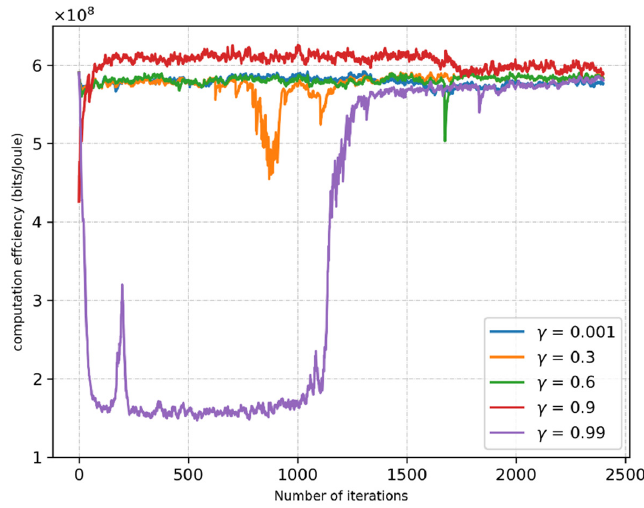
Figure 4. Convergence performance with different discount factors.